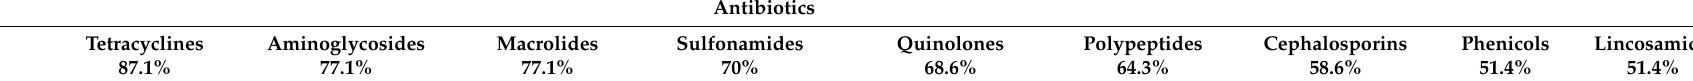
Table 1. Categorization per family of veterinary antibiotics for food-producing animals, representing their occurrence (%).